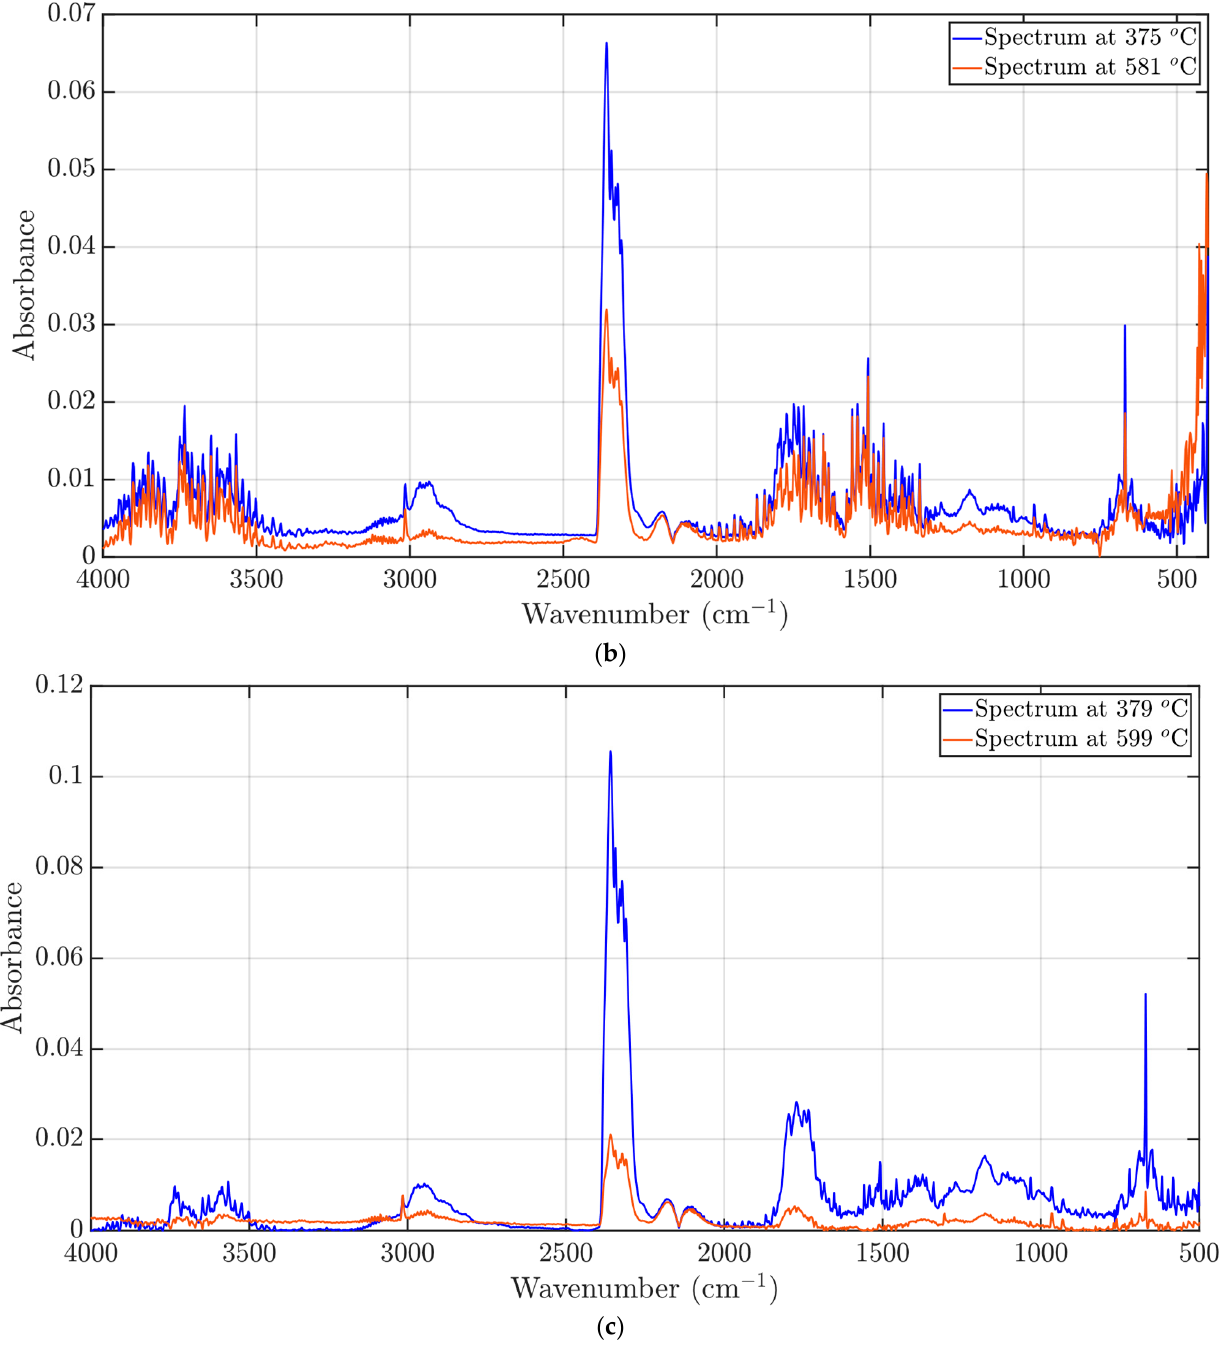
Figure 5. FTIR spectrum of EFB sample: ( a ) 10 K/min, ( b ) 30 K/min, and ( c ) 50 K/min